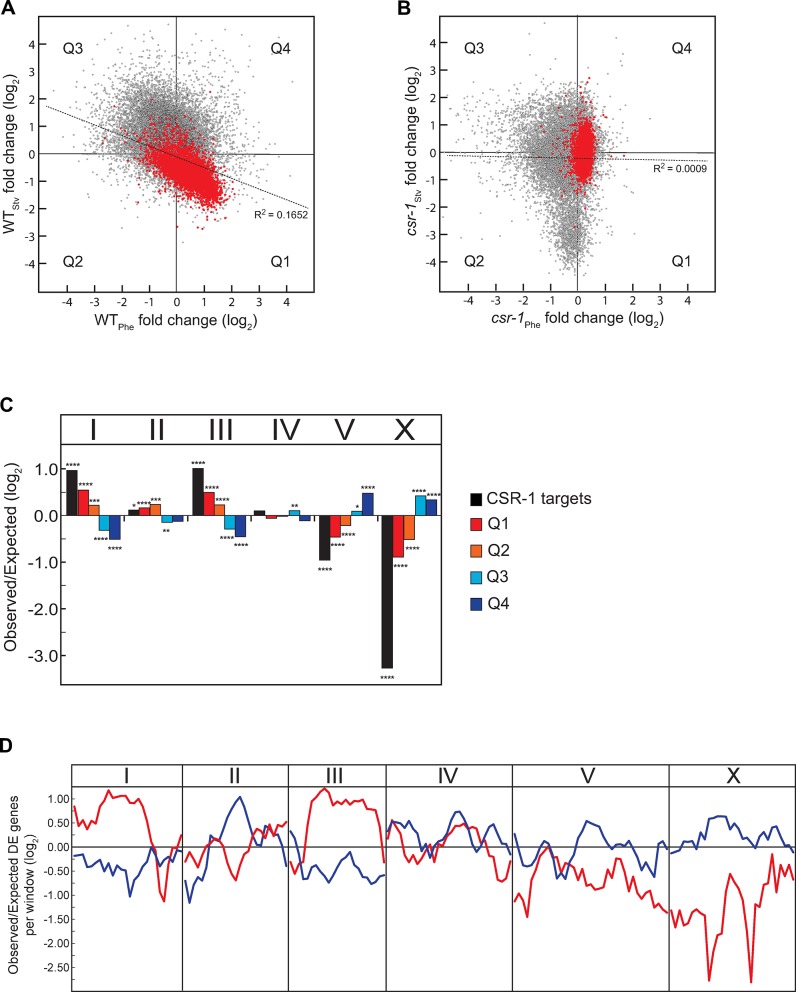
Seesaw changes of gene expression occur genome-wide.(A, B) PD/CON mRNA levels of all genes using the log2 transformed EdgeR fold change values in (A) WTPhe and WTStv or (B) csr-1Phe and csr-1Stv. CSR-1 targets are indicated in red. Significance of correlation was calculated based on the Pearson's correlation between samples. Genes are categorized by quadrant that correspond to their PD/CON mRNA levels in Phe and Stv conditions. (C) Chromosomal bias of CSR-1 targets and expression changes for all genes. Genes are categorized by quadrant as shown in Fig 5A. * p < 0.05; ** p < 0.001; *** p < 0.001; **** p < 0.0001; χ2comparison to uniform distribution based on gene number per chromosome. (D) Sliding window analyses of physical distribution of genes with a 2-fold and greater change in PD/CON mRNA levels for WTPhe up::WTStv down (red line) and WTPhe down::WTStv up (blue line) genes relative to a uniform distribution across the genome.